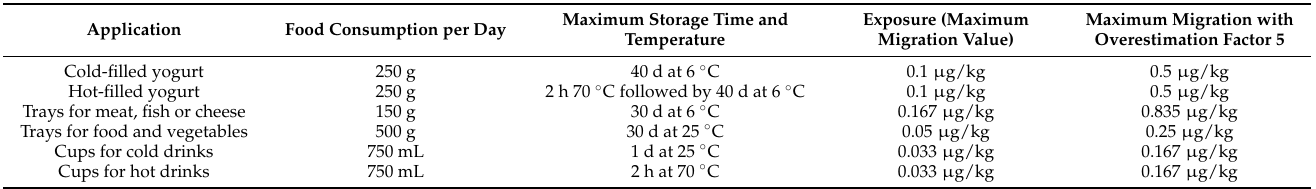
Table 2. Migration scenario for calculations for toddlers with 10 kg body weight. Values for food con- sumption, maximum storage temperatures, admissible exposure and values for maximum migrated quantity are